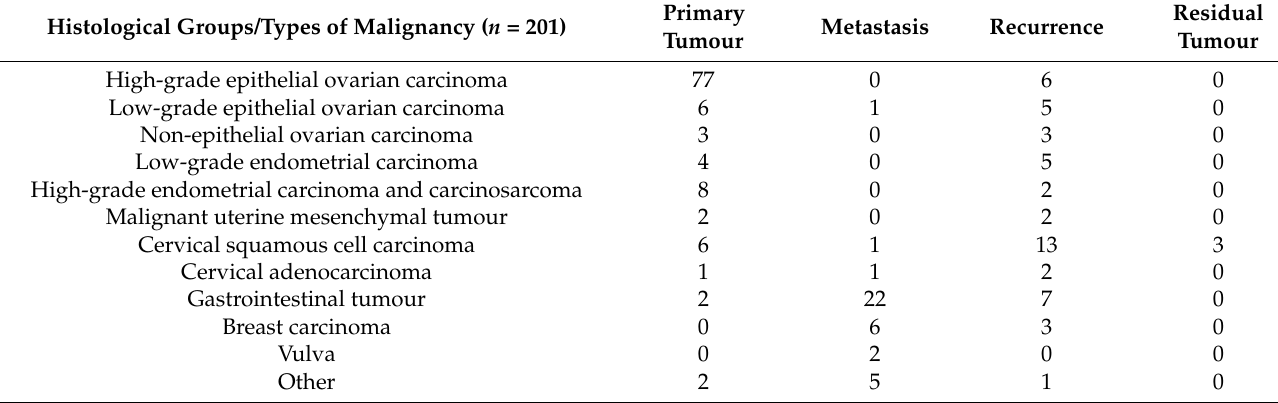
Table 3. Characteristics of the histological